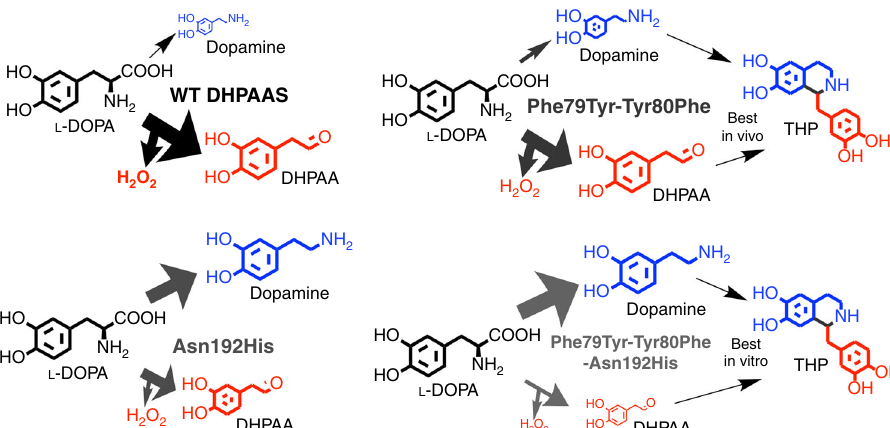
Fig. 8 General scheme of tuning engineered DHPAAS variants for THP production. Based on the activities presented in Table 1, major products are presented as larger sized molecules relative to the scale of minor